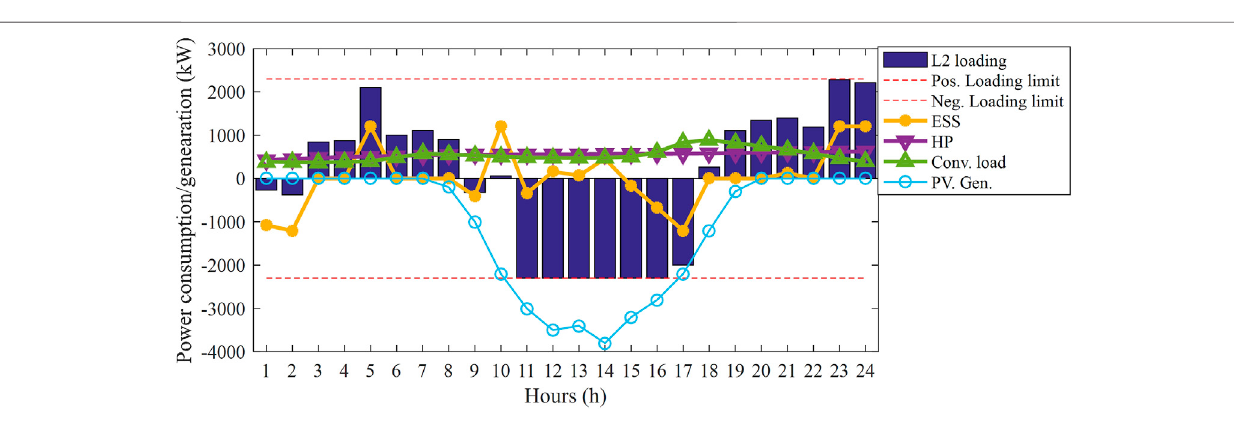
Frontiers in Energy Research |